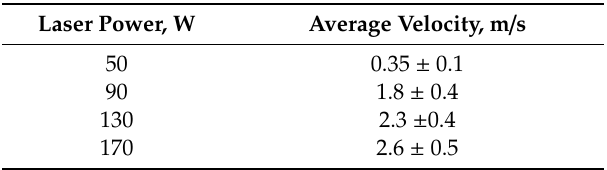
Figure 6. Sequential frames of a steady-state vapor-gas jet at laser power of ( a ) 50 and ( b ) 130 W. Table 2. Gas-phase flow